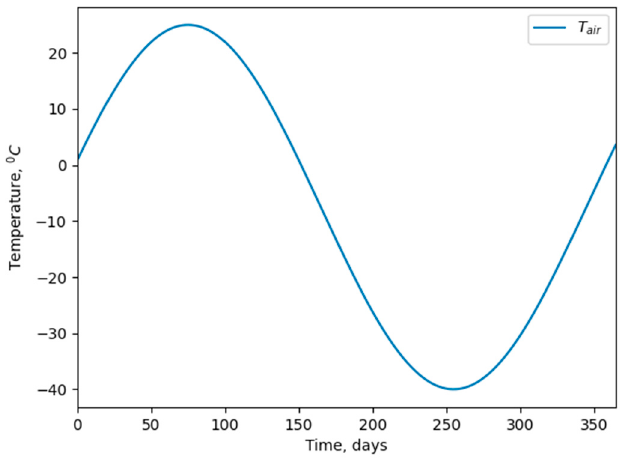
Figure 3. Air temperature.